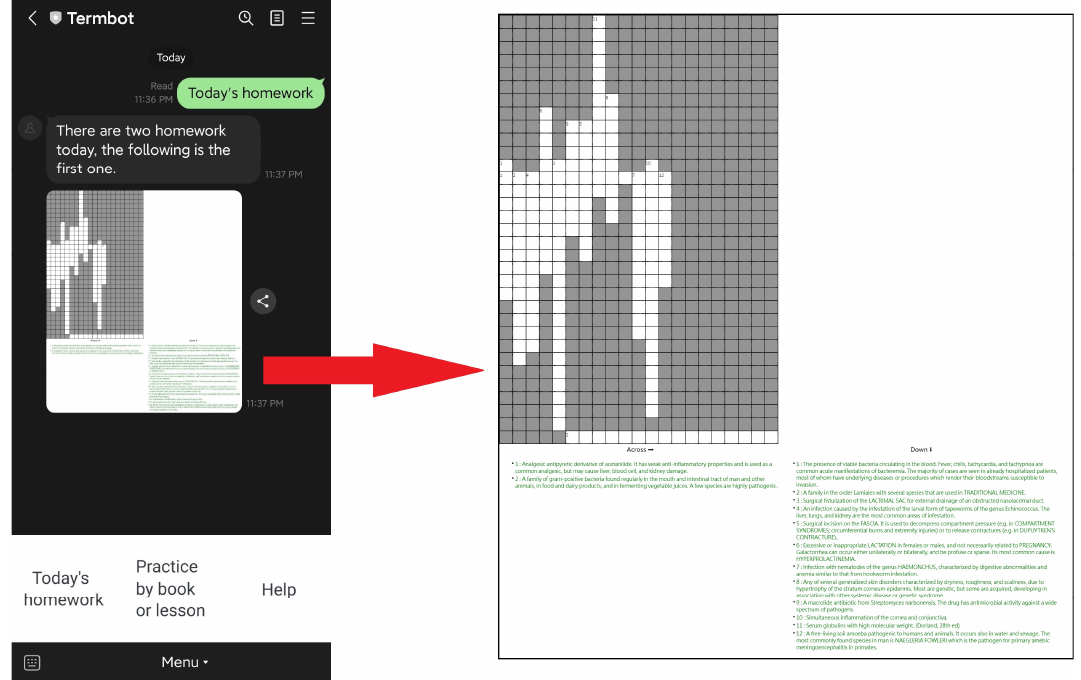
Figure 4. The function “Today’s homework”.